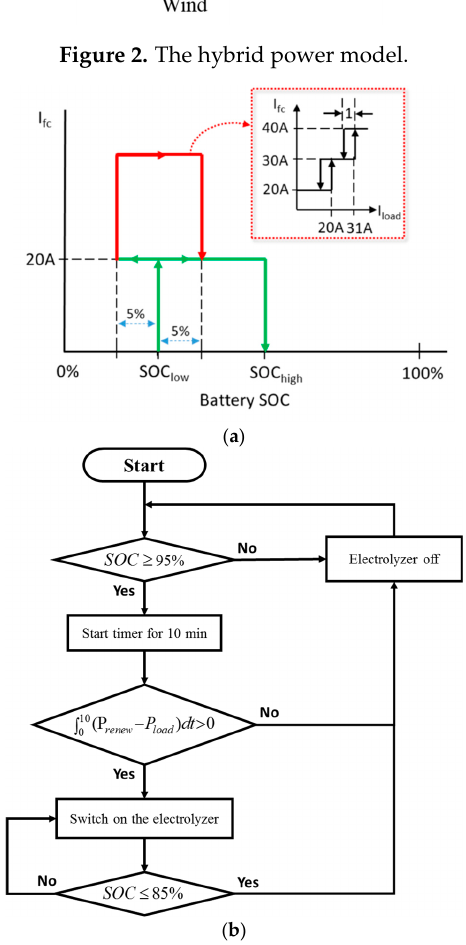
Figure 2. The hybrid power model. Energies 2018 , 11 , x FOR PEER REVIEW